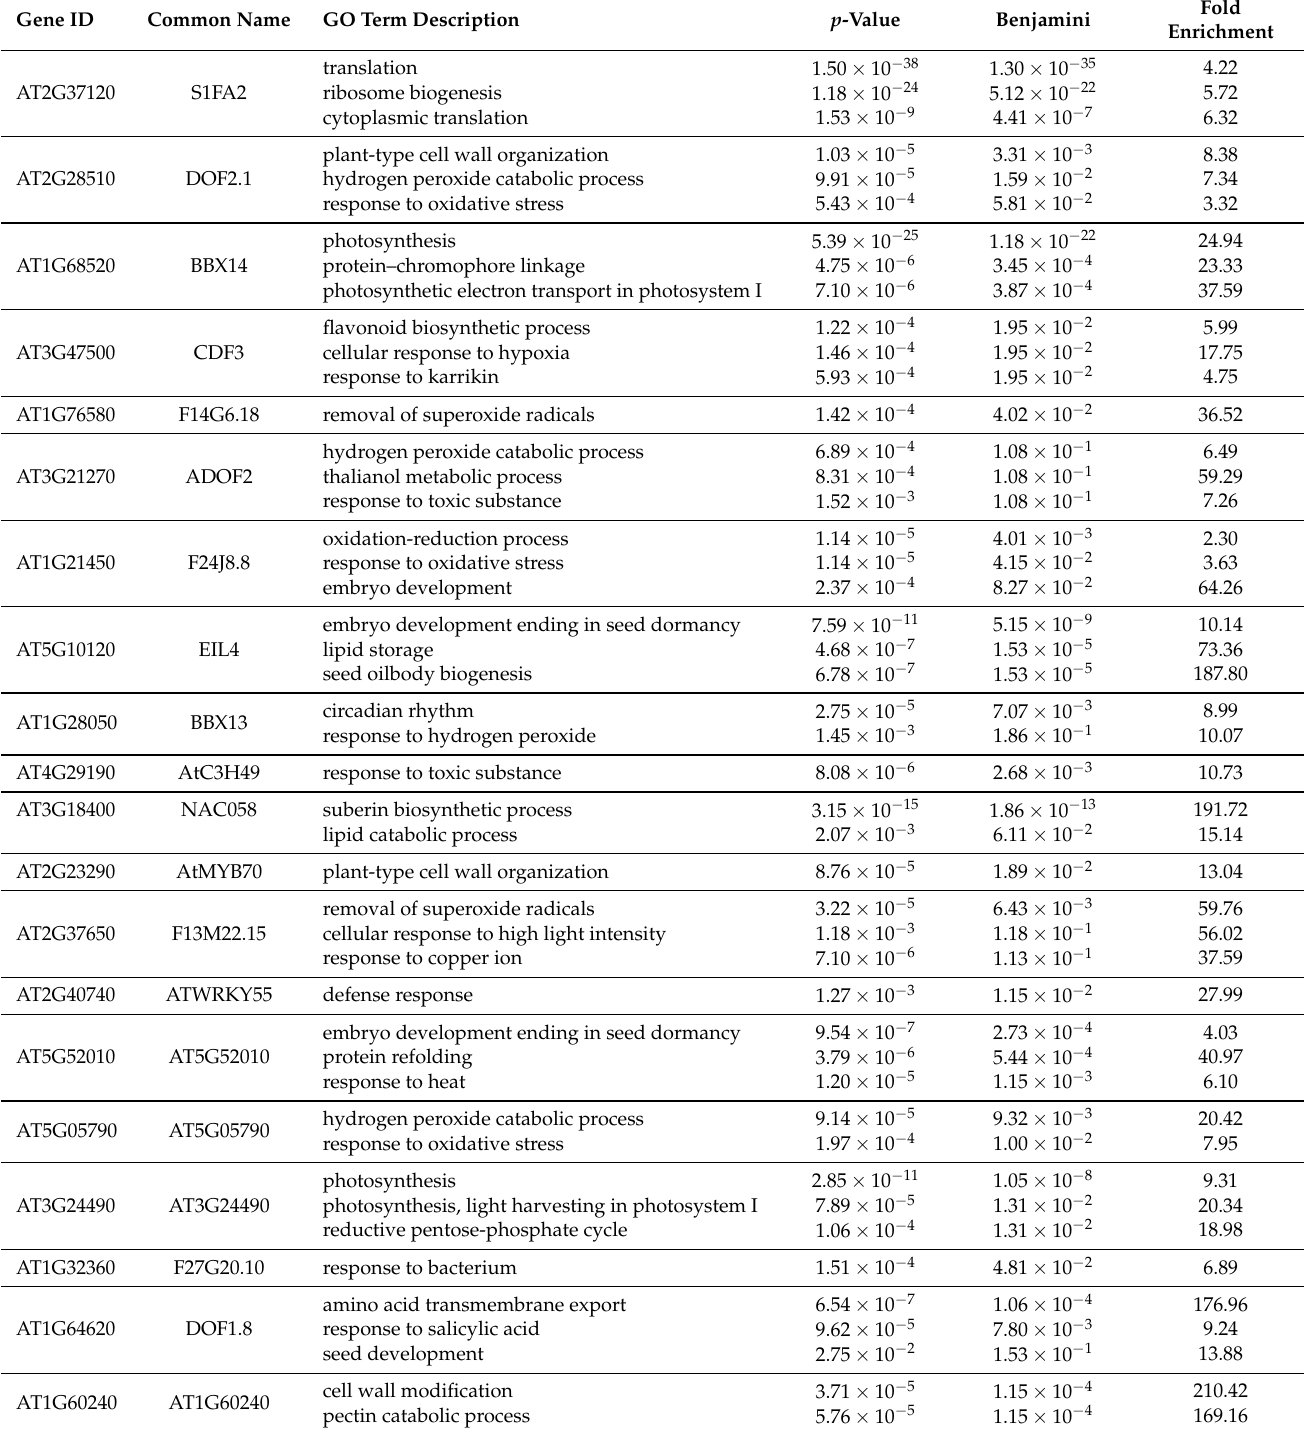
Table 2. Novel functional annotations for a few transcription